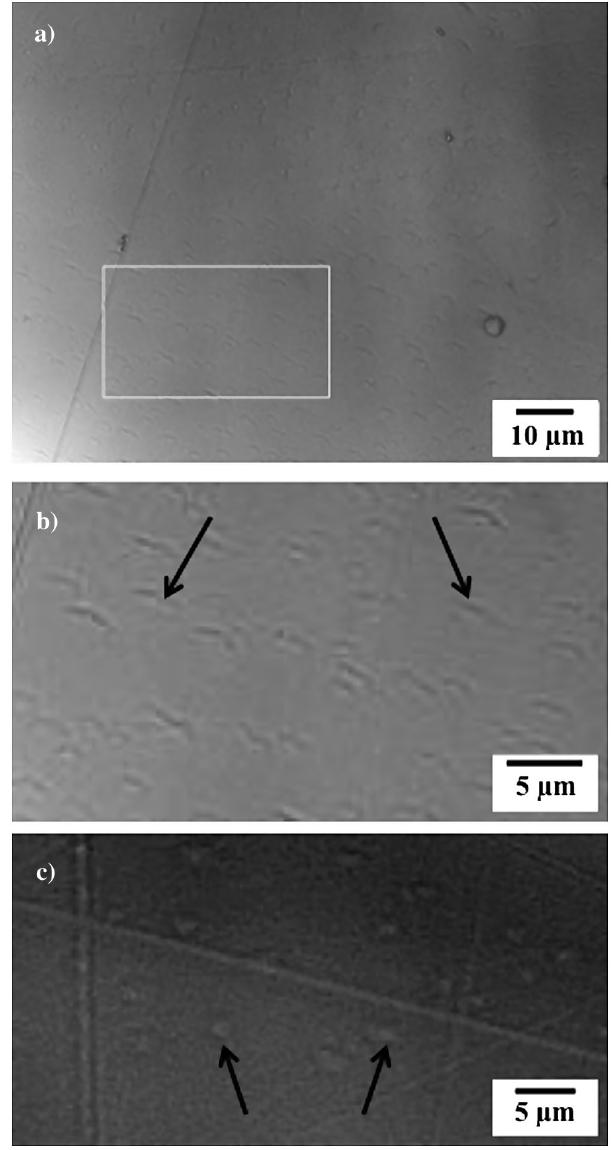
FIG. 2. (a) Lenslike structures after 77 K hold on a fine grain mechanically polished sample; (b) zoom-in from the selected area, arrows indicate surface relief due to hydrides; (c) smaller structures observed at another location.